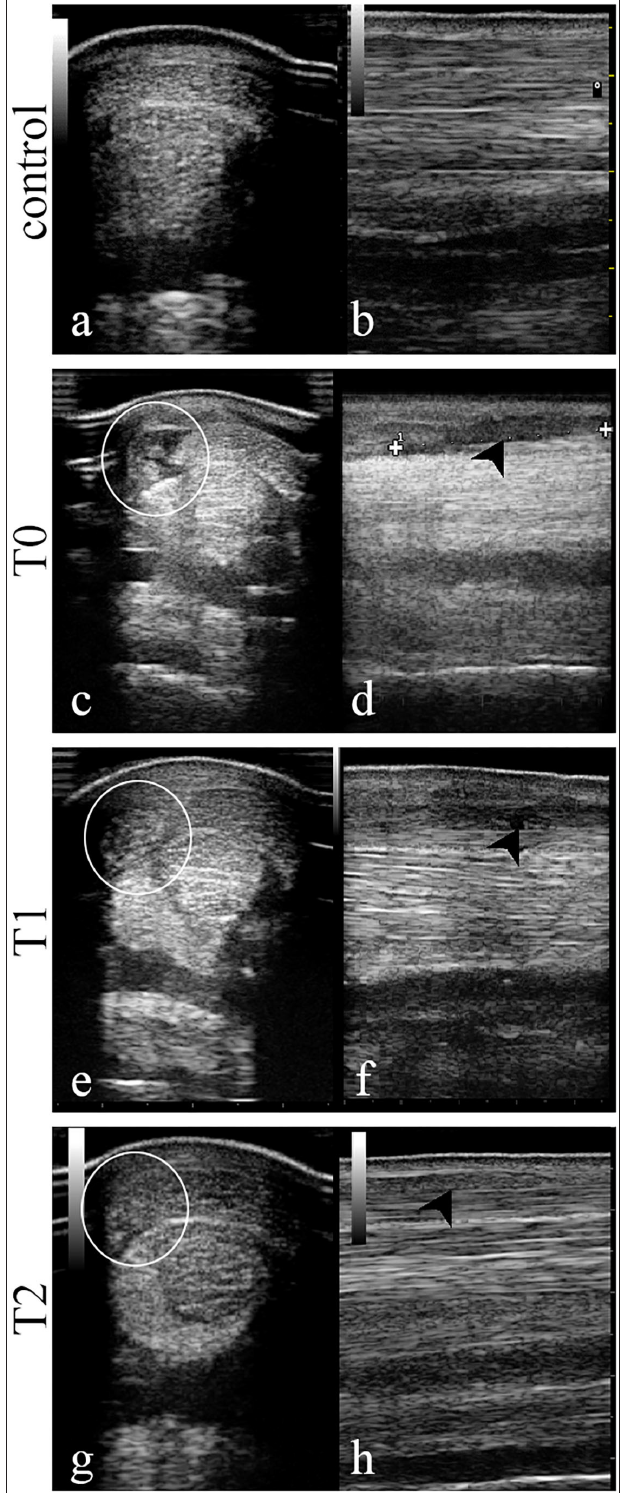
FIGURE 2 | Transversal and longitudinal images of the central area of the superficial digital flexor tendon in the mid-metacarpal region performed at day 0 (T0, day of therapy injection), T1 (4 weeks), and T2 (52 weeks). At T0 the